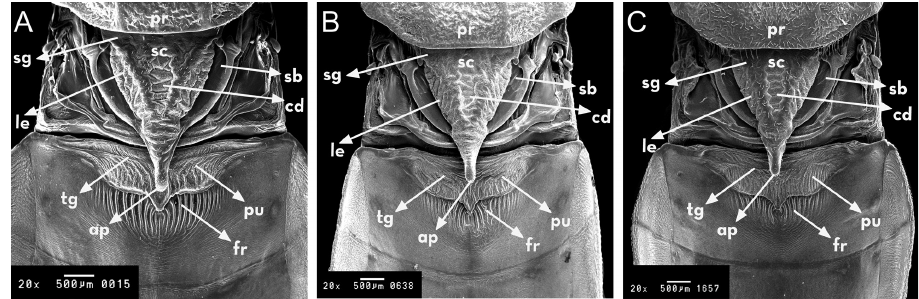
Figure 4. Escutellum and process of I urotergit of R. marabaensis sp. n. ( A ), R. prolixus ( B ), R. robustus ( C ). pr: pronotum; sc: escutelum; sb: semi- circular base; sg: glabrous space; cd: central depression; le: lateral edge; ap: apex of escutelum; pu: process of I urotergit; tg: transverse groove; fr: fringe.